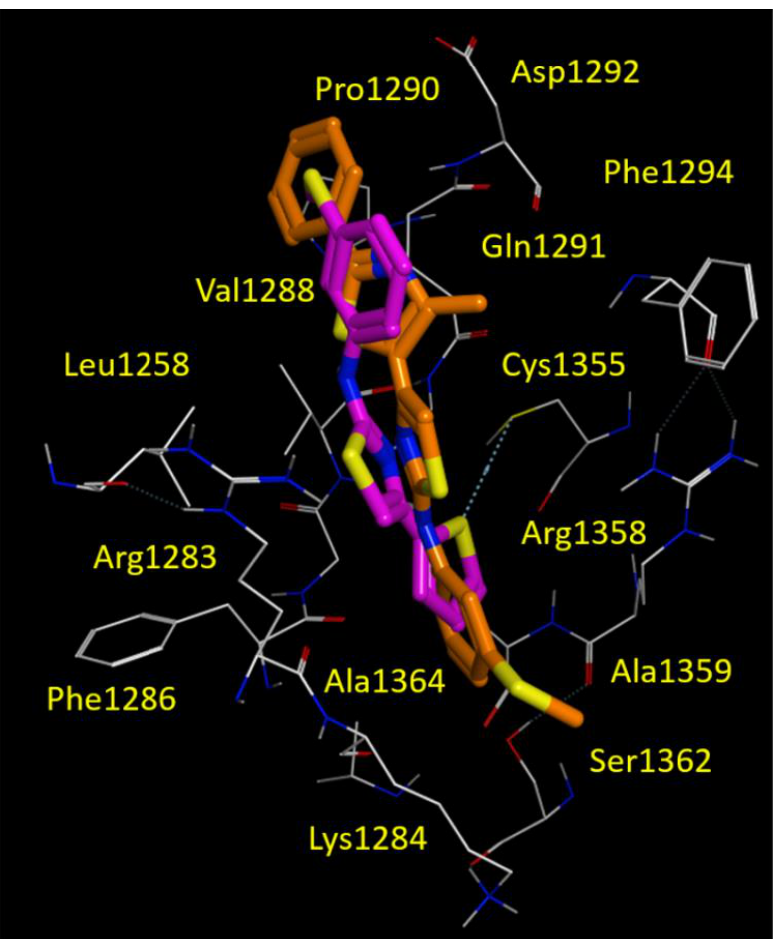
Figure 8. Docking positioning of the AAT 9d (C atom; magenta) and 10d (C atom; orange) at the CFTR NBD2 domain (PDB code = 6UK1). All residues placed 3.5 Å from the ligands are shown. Hydrophobic, polar, negatively and positively charged amino acids are shown in green, pink, and by red and blue circled pink labels,